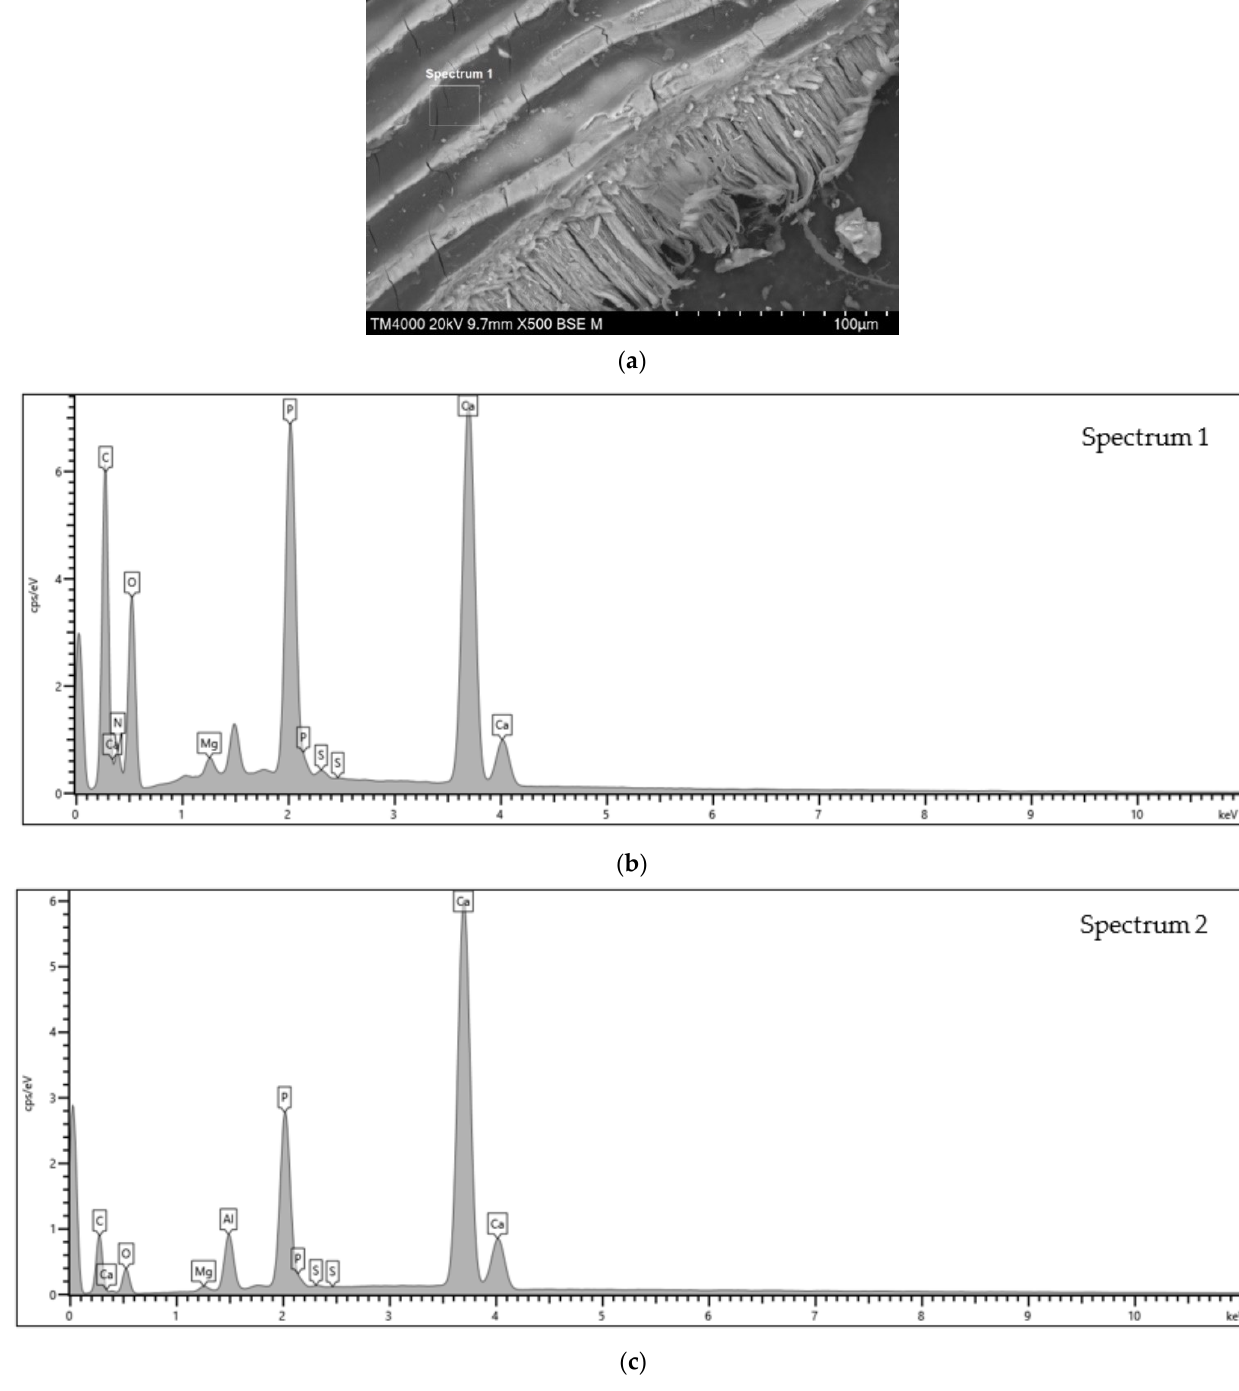
Figure 5. SEM micrograph of the powder Cyprinus carpio scales 500× ( a ); EDX spectra corresponding to the two regions identified on the surface of the scales: ( b ) darker-spectrum 1 and ( c ) whiter-spectrum 2. Table 3. EDX analysis of the Cyprinus carpio scales before and after 240 min of contact with the acidic mine drainage solution.